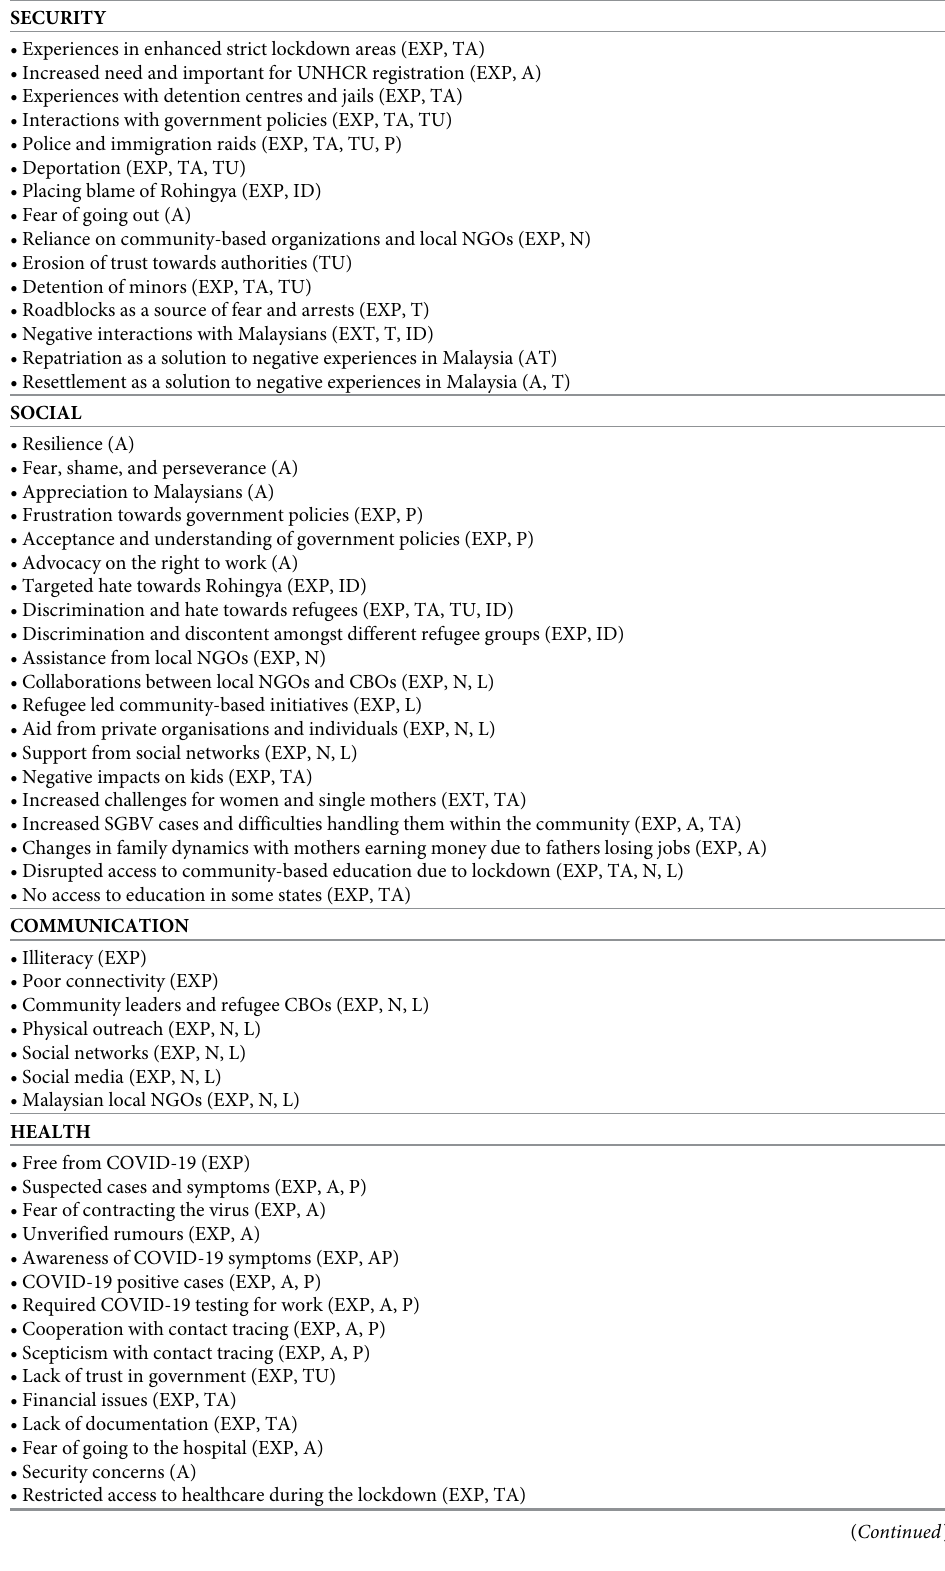
Table 1. Themes obtained from the thematic content analysis of first-round interview